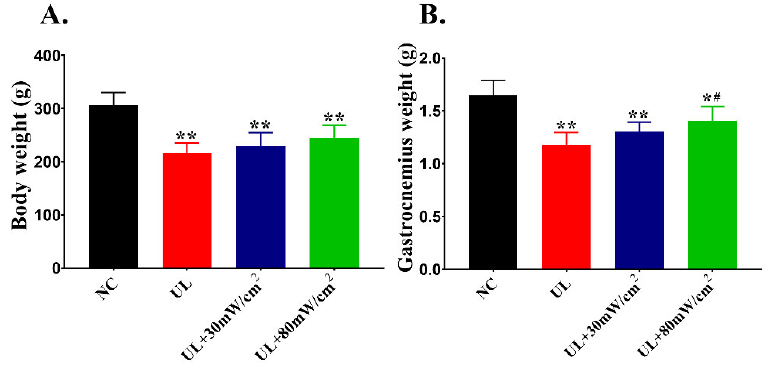
Figure 1. ( A ) Body weight. ( B ) Gastrocnemius muscle weight. The data were expressed as mean ± SD ( n = 8 in each group), ** p < 0.01 vs. NC group, * p < 0.05 vs. NC group, # p < 0.05 vs. UL group.